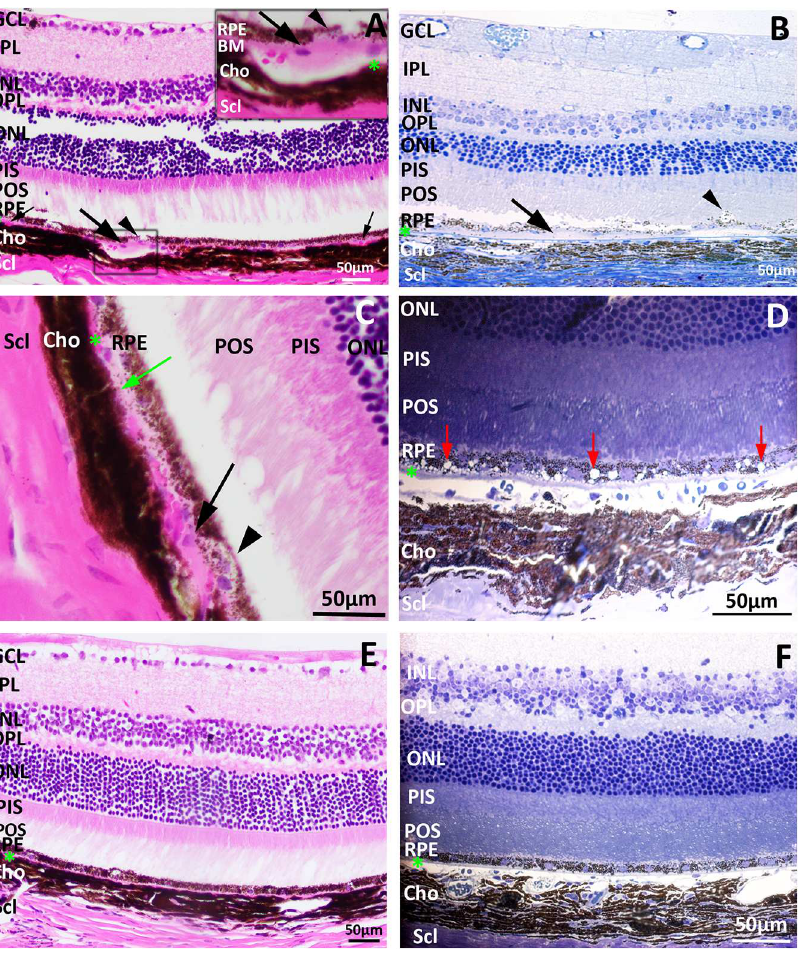
Fig 3. Drusen-like, sub-RPE deposition, and RPE vacuolization in aged Cxcr5 -/- mice. Retinal cross sectionswere preparedfrom 17-month-old Cxcr5 -/- mice ( A - D )and C57BL/6WT control mice ( E and F ). Cryo- preserved sections were stained with H & E ( A , C , and E ). Plastic sections were stained with toluidineblue ( B , D , and F ). ( A ) Drusen-like deposits. Large arrows indicatedthe dome-shaped drusen-likedepositsbetween the RPE and Bruch’s membrane(BM, green asterisks). Small arrows indicatedthe two small drusen-like deposits. Inset showedthe drusen-like depositsin the box. Arrowheads indicatedthe degeneratedRPE. ( B ) Sub-RPE deposits(arrows) and RPE distentioninto the subretinal space (arrowhead). ( C ) BM degeneration (green arrow), BM thickening(black arrow), and RPE atrophy (arrowhead). ( D ) Numerousvacuolesin RPE (red arrows). ( E and F ) H & E-/ toluidineblue-stained sections from the WT control mice. Three to five mice from each group were used. GCL: ganglioncell layer; IPL: Inner plexiform layer; INL: inner nuclear layer; OPL: outer plexiform layer; ONL: outer nuclear layer; PIS: photoreceptor inner segment; POS: photoreceptor outer segment; RPE: retinal pigmentepithelium;Cho: choroid; Scl: sclera. Green asterisk: Bruch’s membrane